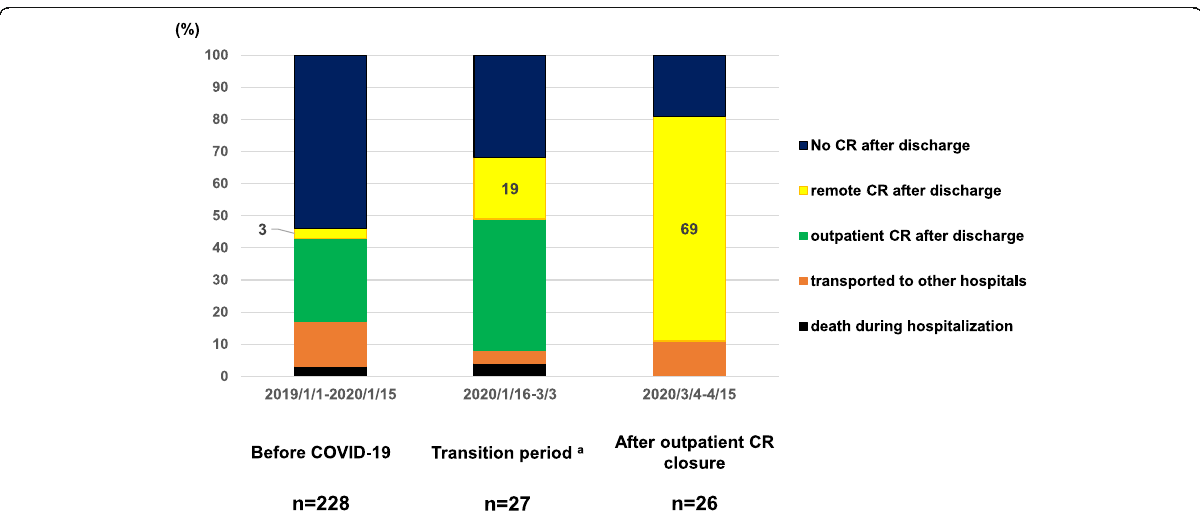
Fig. 2 Remote cardiac rehabilitation for patients with heart failure before and during the COVID-19 pandemic. CR after discharge for patients with HF before and during the COVID-19 pandemic. Superscript letter “ a ” denotes the period from the first report of COVID-19 in Japan to outpatient CR closure in our hospital. CR, cardiac